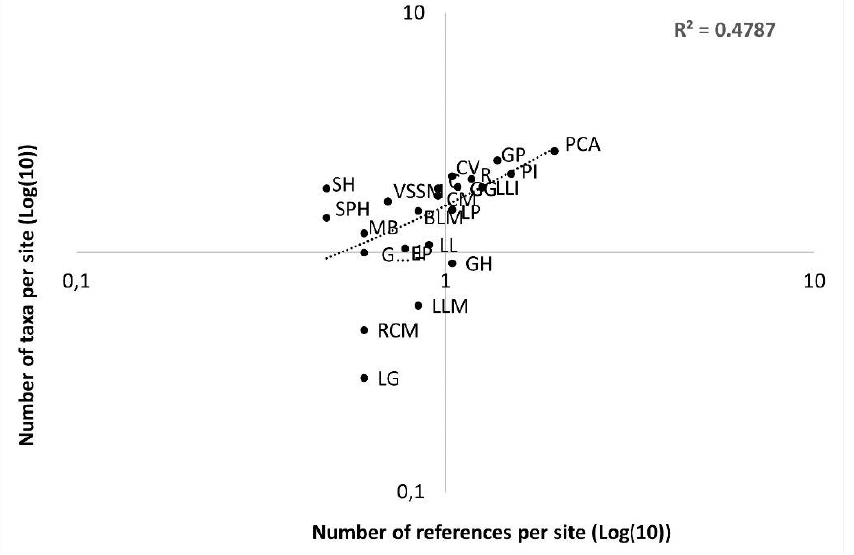
Figure 3. Number of reported taxa (in blue) and literature documents (in green) per locality and site (in red).